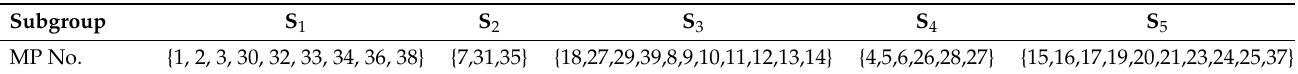
Table 2. MP classification results.